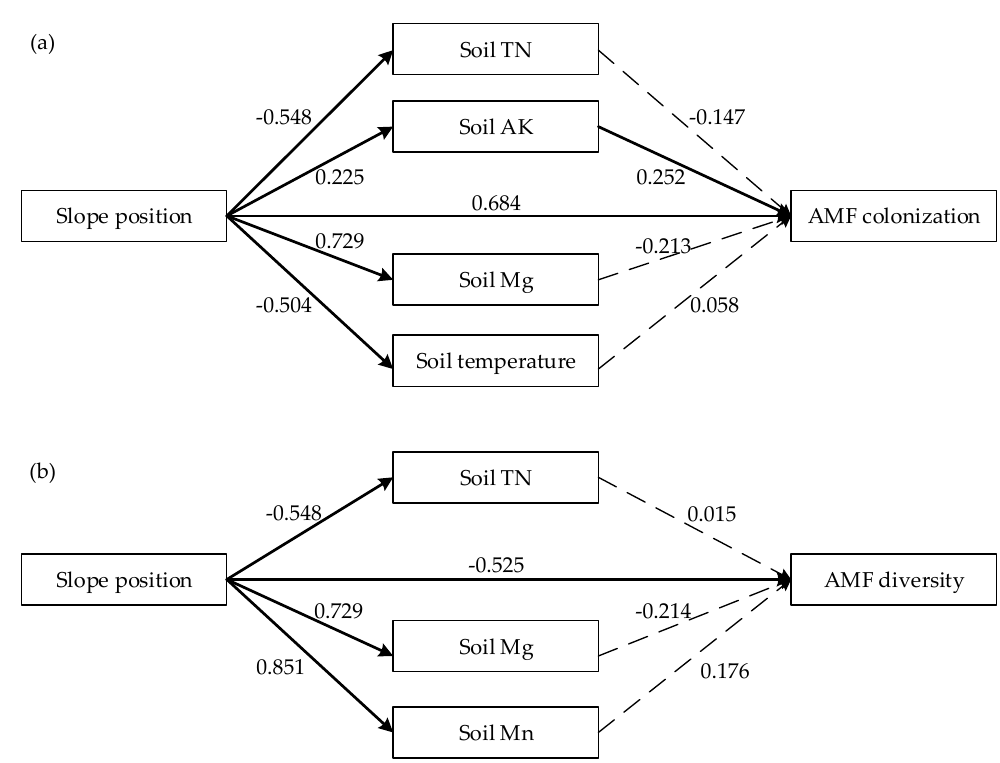
Figure 4. Structural equation model (SEM) results allow us to infer the plausible causal effects of slope position and soil factors on ( a ) AMF colonization and ( b ) diversity. Bold and dashed lines indicate significant and non-significant pathways, respectively. The final model fit the data well: ( a ) χ 2 = 13.676, df = 6, p = 0.033; AIC = 43.676; RMSE = 0.120. ( b ) χ 2 = 13.282, df = 3, p = 0.004; AIC = 37.28; RMSE = 0.196.